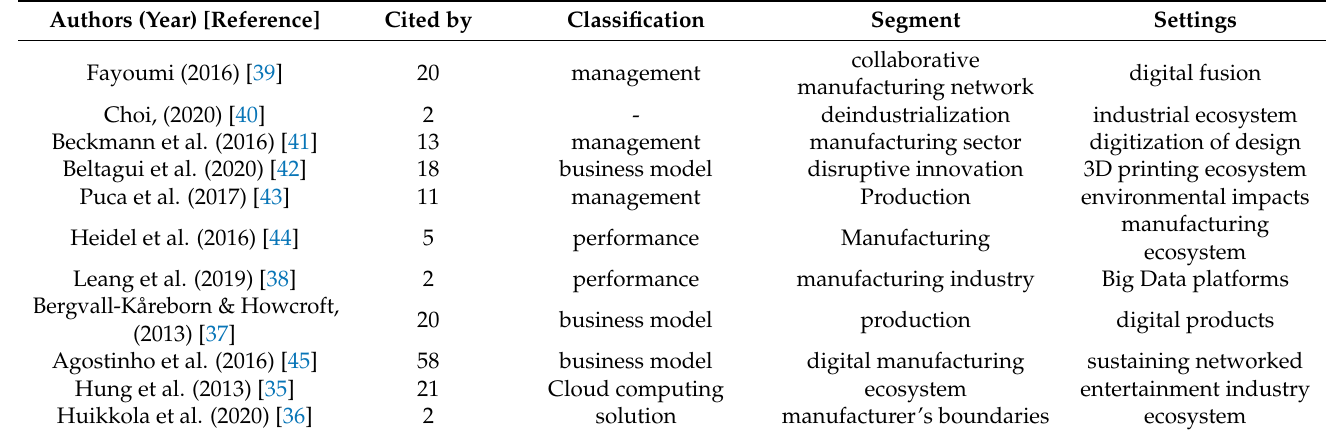
Table 4. Distribution of author, citations, and classifications from